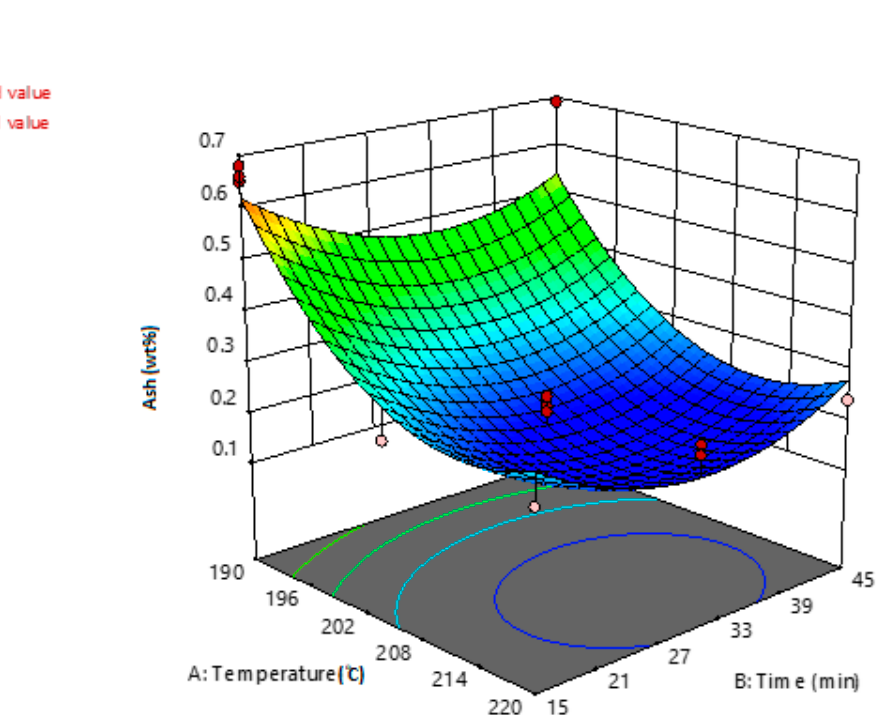
Figure 3. 3D response surface plot of the ash content considering the interactions of temperature and